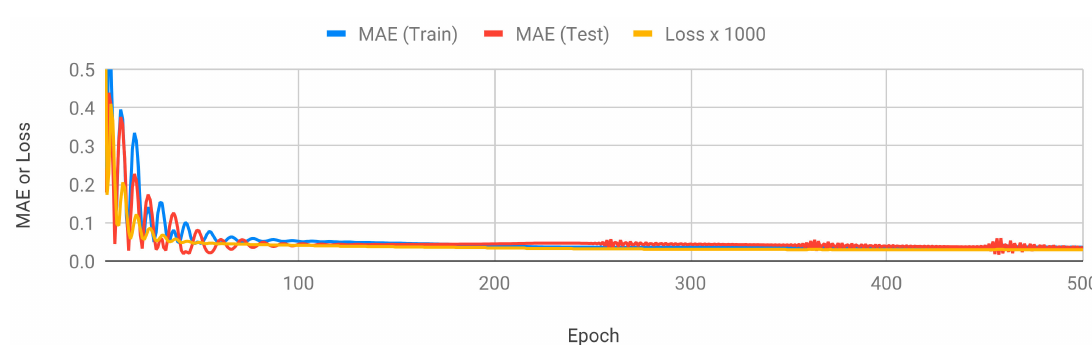
Figure 7. MAE and loss values of